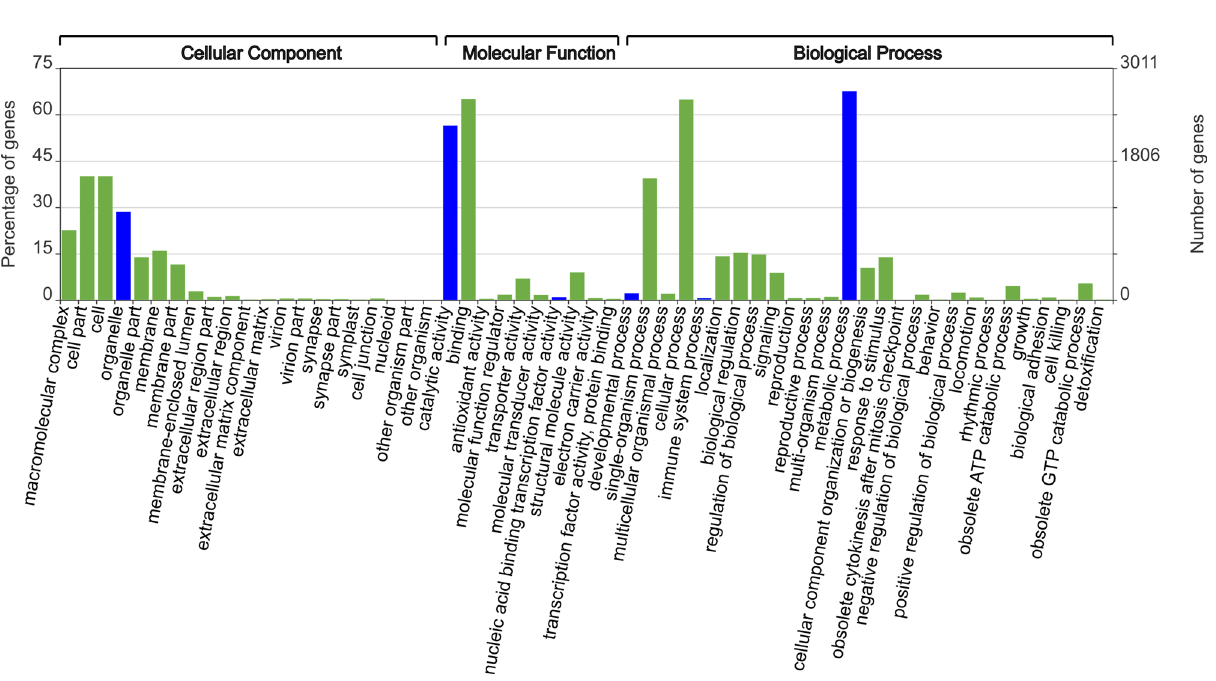
Figure 3. Level 2 Gene Ontology (GO) analysis of T. bryosalmonae intersect transcriptome. Functional annotation of the 4015 annotatable contigs were assigned to 9107 GO terms and grouped based on their predicted properties and function. The x-axis displays the GO terms selected from the GO trees. The left and right y-axes correspond to percentage gene number and actual gene number per selected GO term respectively. GO terms of relevance to further characterisation in this study are highlighted in